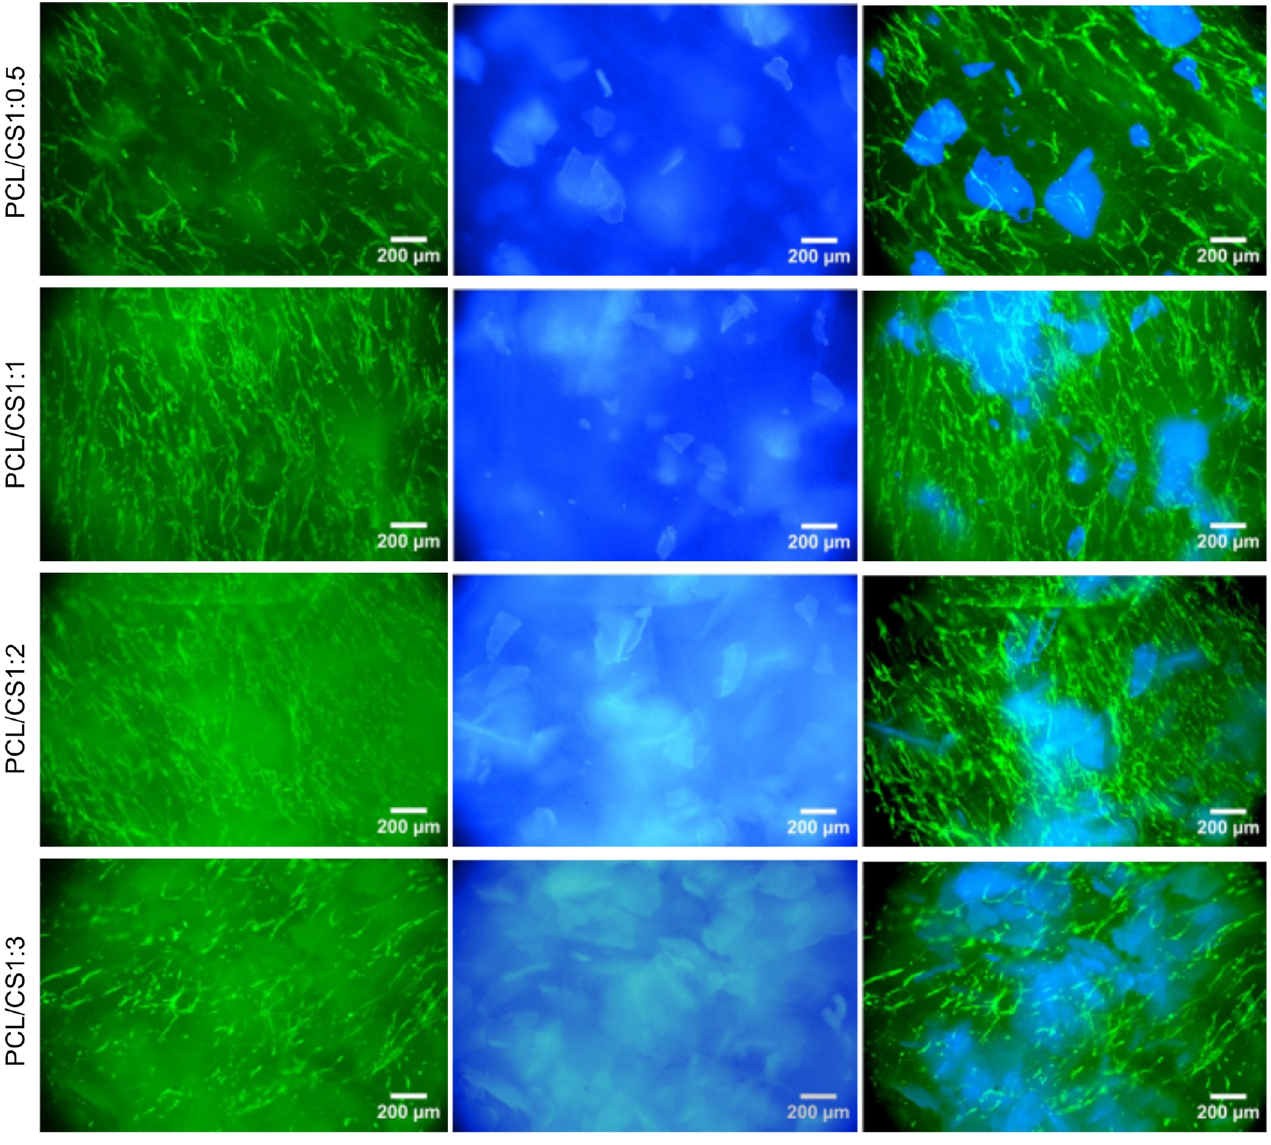
Figure 8. Fluorescent images of HFFF2 cells stained with calcein (green) at day 14 of culture, when growing on PCL mats, PCL mats with CS flakes of different sizes and PCL mats with CS flakes at different ratios ( left column ); autofluorescence of hybrid scaffolds when excited with UV light due to the presence of CS ( middle column ); composite images ( right column ).